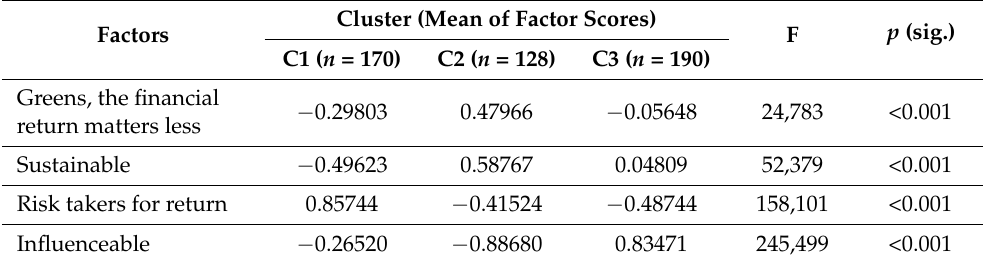
Table 3. Clusters